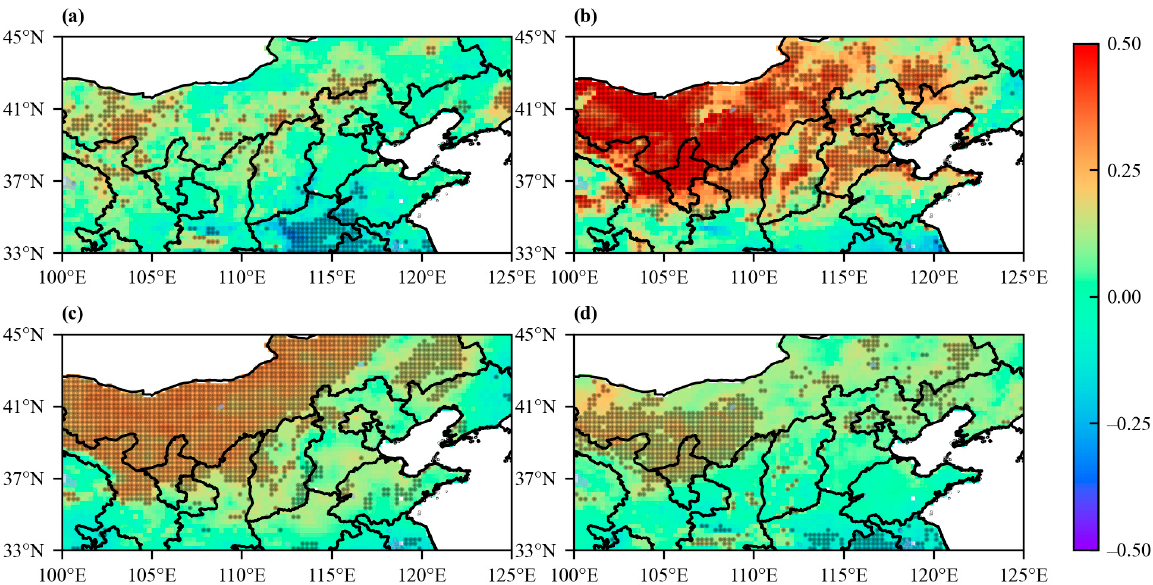
Figure 4. Spatial distribution of evapotranspiration-precipitation CS in the climate transitional zone of northern China (dot denotes CS passing 0.05 significance test).